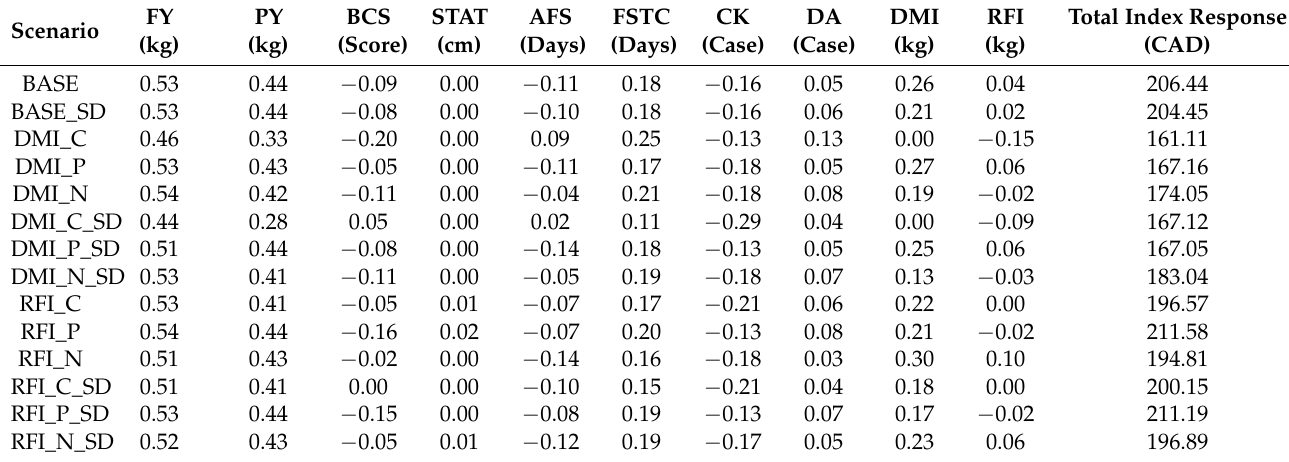
Table 4. Genetic gain per year (in genetic standard deviations) and the total index response to selection